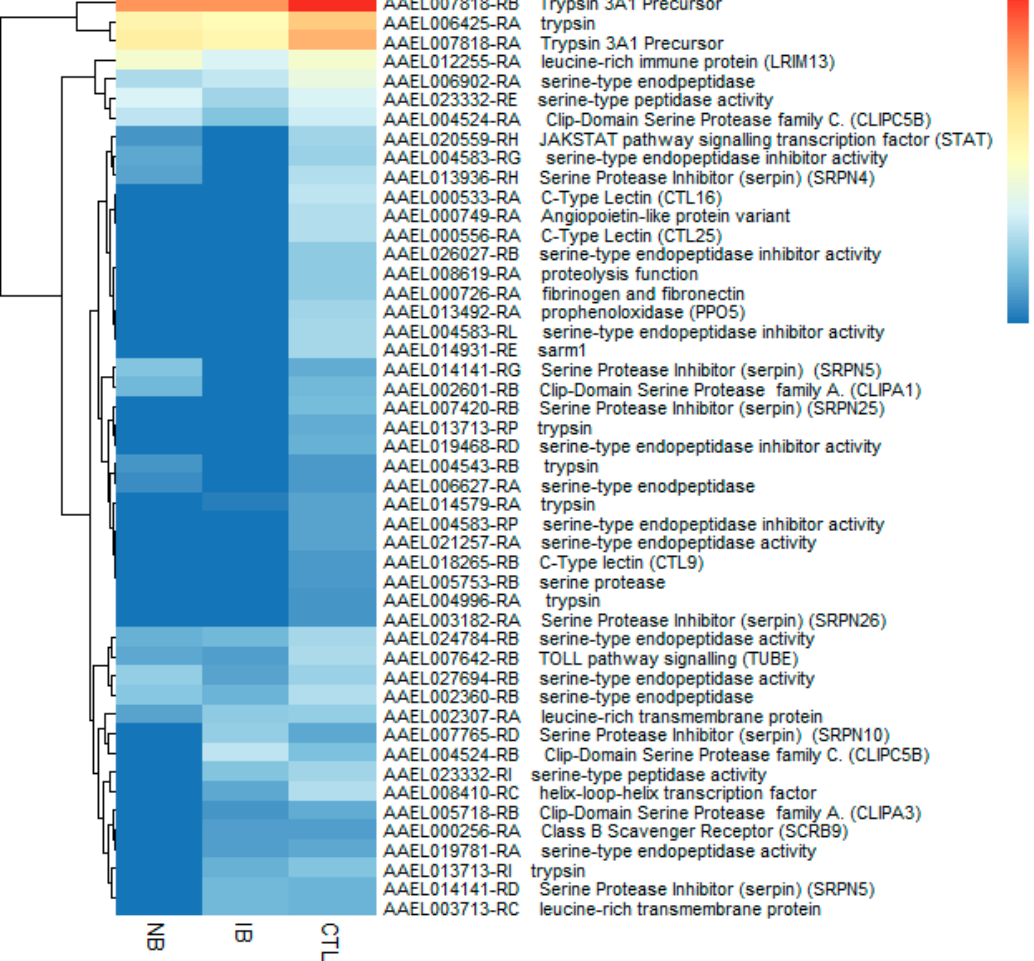
Figure 4. Heatmap showing the expression profile of 48 IRT found as downregulated in the in vivo treatments. Normal blood (NB). Heat-inactivated blood (IB). Sugar meal treatments. Normal blood (NB). Heat-inactivated blood (IB). Sugar meal (Ctl).